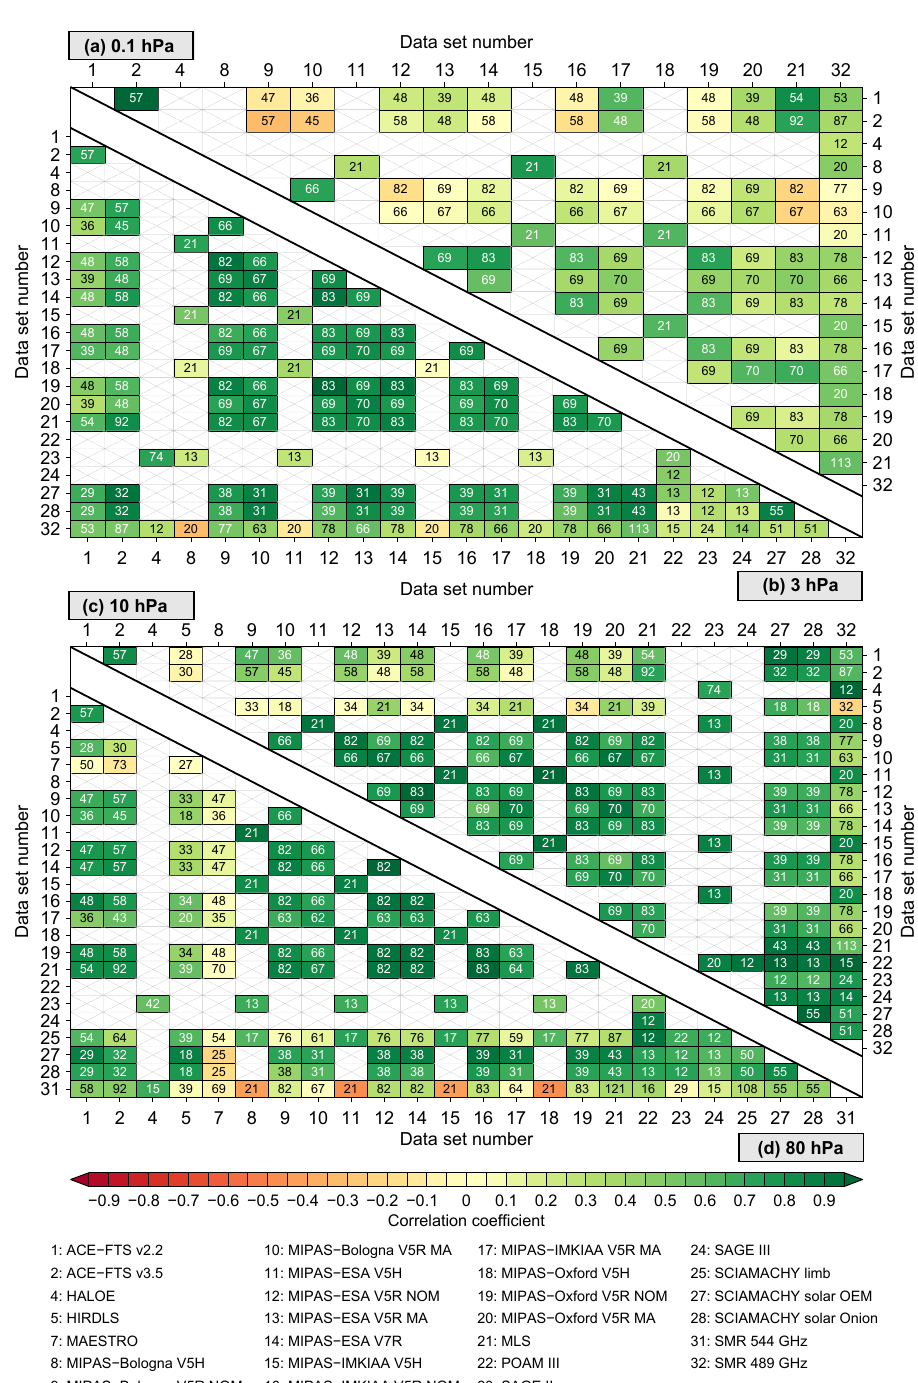
Figure 9. As Figs. 7 and 8, but considering the latitude band between 50 ◦ and 60 ◦ N.